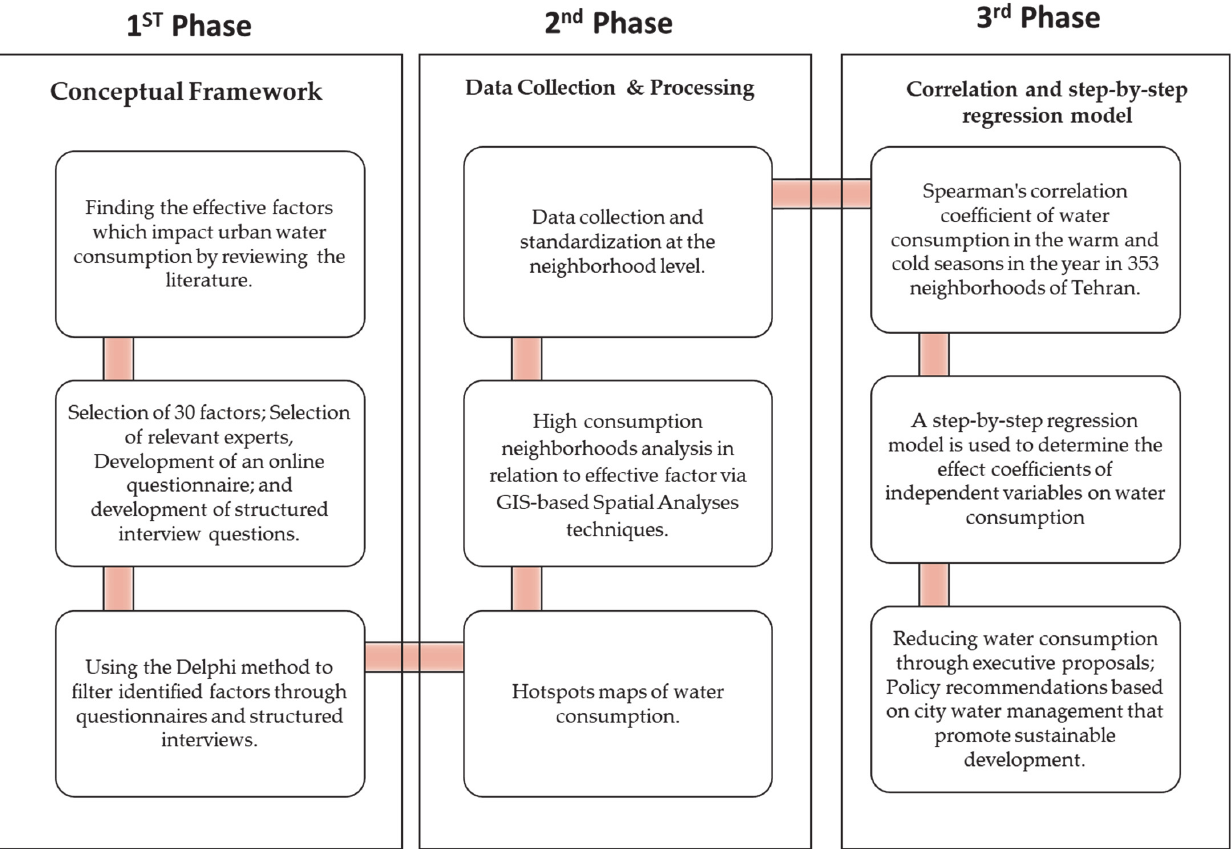
Figure 5. Diagram of the methodology.